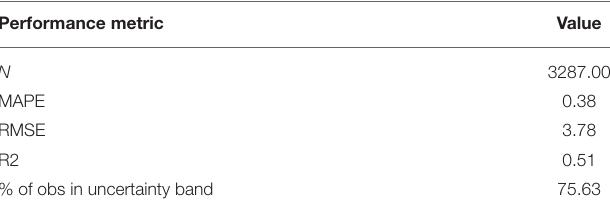
TABLE 1 | Time series forecasting validation metrics against fused observations. Performance